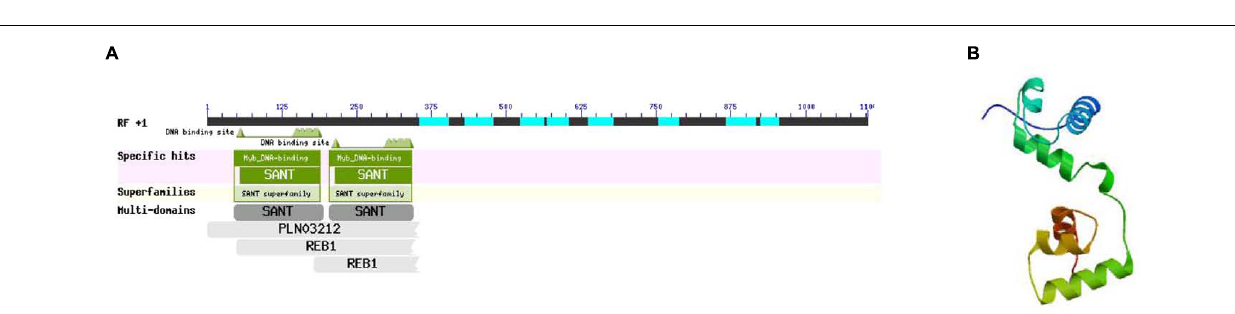
Frontiers in Plant Science |